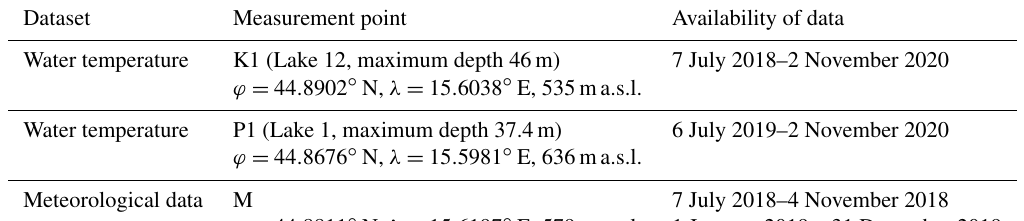
Table 2. Availability of measured data. The positions of the measuring points are shown in Fig. 1.